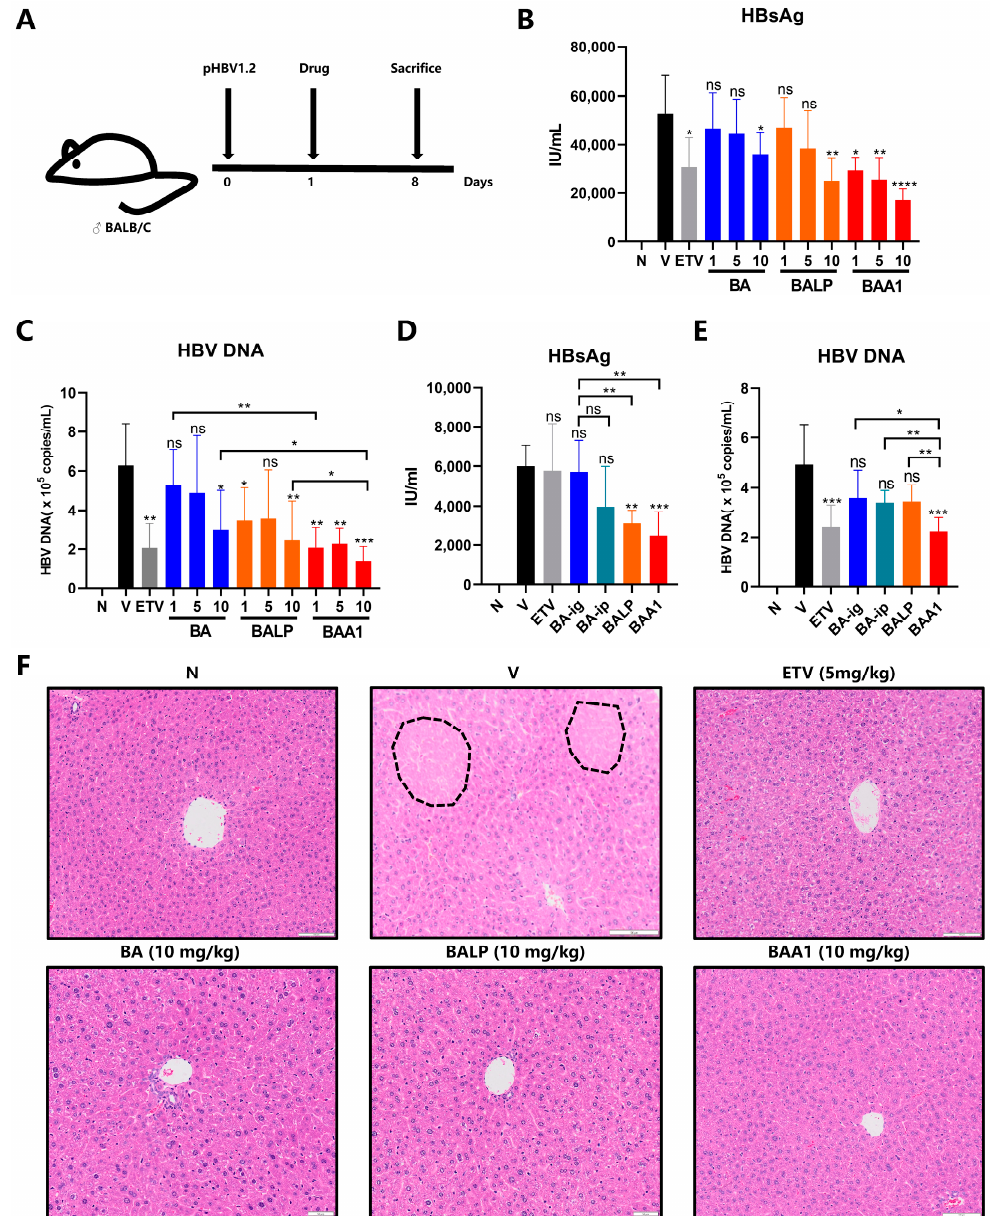
Figure 8. Anti-HBV efficacy of different baicalin preparations in vivo. ( A – C ) HBV transient mice were hydrodynamically injected with pHBV1.2 plasmids. The infected mice received oral administration of BA (1, 5, 10 mg/kg); ETV (5 mg/kg); intraperitoneal injection of BALP (1, 5, 10 mg/kg); or BAA1 (1, 5, 10 mg/kg) once a day for 7 days. The mice were sacrificed for their serum HBsAg and HBV DNA, with detection by ELISA and qPCR, respectively. Data are presented as mean ± SD, n = 3; * p < 0.05, ** p < 0.01, *** p < 0.001, and **** p < 0.0001 vs. control. ns, not significant. ( D , E ) The infected mice received oral administration of BA (5 mg/kg); ETV (5 mg/kg); intraperitoneal injection of BA (5 mg/kg); BALP (5 mg/kg); or BAA1 (5 mg/kg) once a day for 1 week. The mice were sacrificed for their serum HBsAg and HBV DNA. with measurements by ELISA and qPCR, respectively. Data are presented as mean ± SD, n = 3; * p < 0.05, ** p < 0.01, *** p < 0.001, and **** p < 0.0001 vs. control. ns, not significant. ( F ) HE staining of the liver tissues (200 × magnification). Area of necrosis (black dotted line). Scale bar = 100 µ